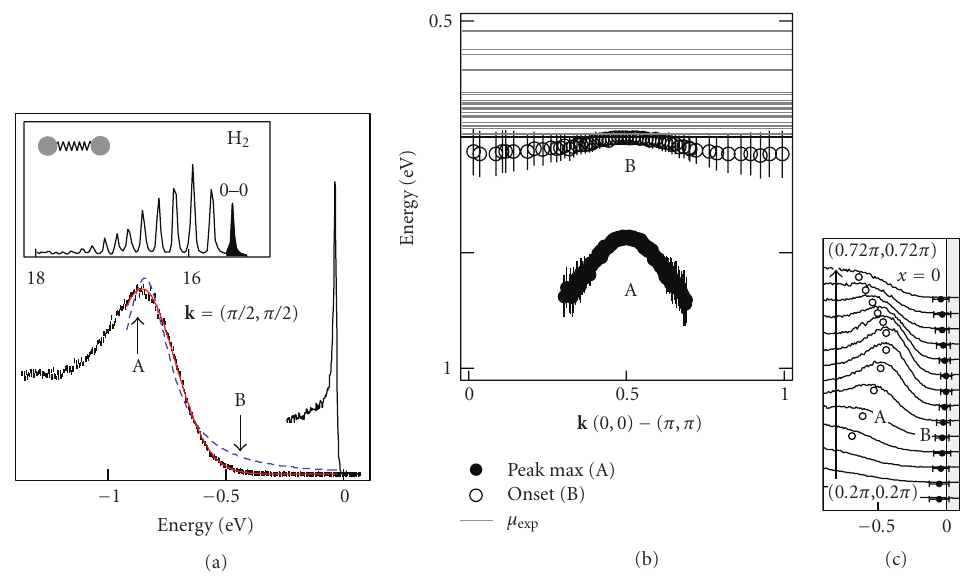
Figure 5: (a) ARPES spectrum of the undoped Ca 2 CuO 2 Cl 2 in the nodal point k = ( π/ 2, π/ 2) fitted by Lorentzian (dashed line) and Gaussian (thick solid line). The notations A and B define the maximum of the peak and the point where spectral density arises, respectively. Narrow peak in the vicinity of zero energy is the ARPES spectrum of SrRuO 4 . (b) Dispersion of A and B. The positions of the chemical potentials for di ff erent samples are shown by the horizontal lines. (c) Experimental ARPES spectra in the vicinity of the nodal point, after Shen et al.